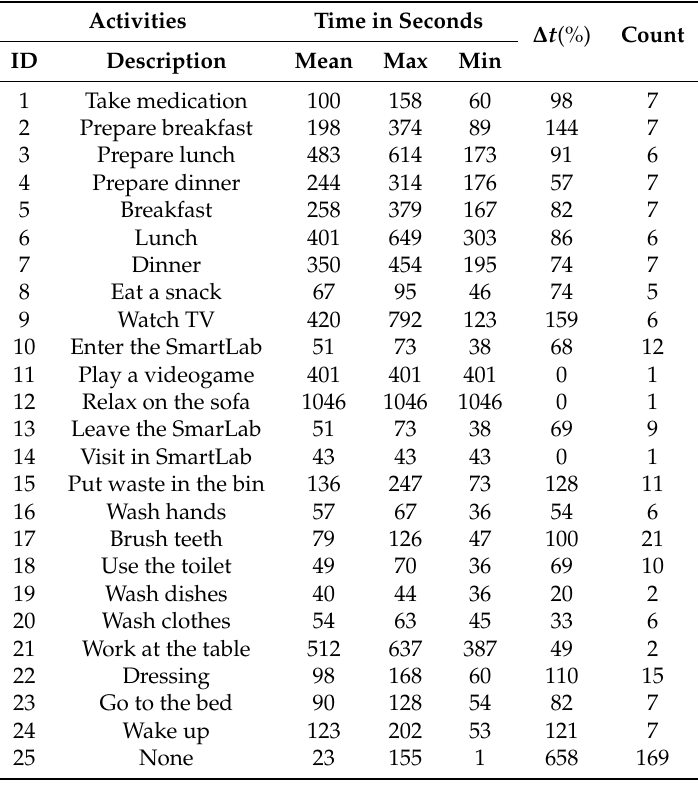
Table 2. Statistics from the training set of activities (7 days).